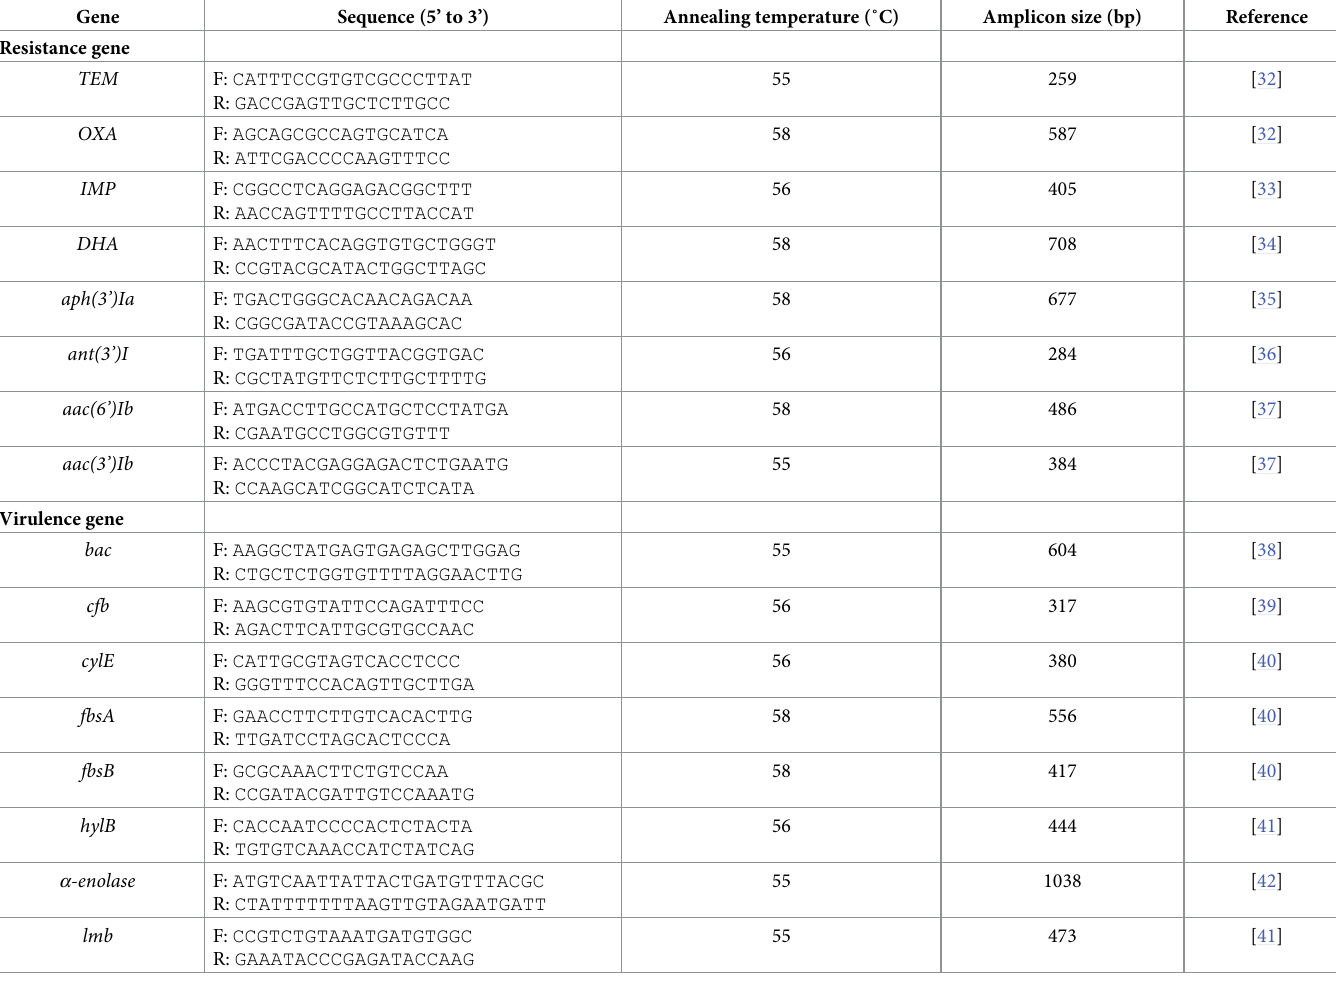
Table 2. Primers of resistance and virulence